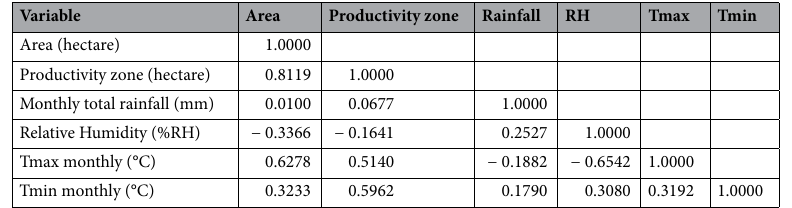
Table 2. Correlation matrix of the input